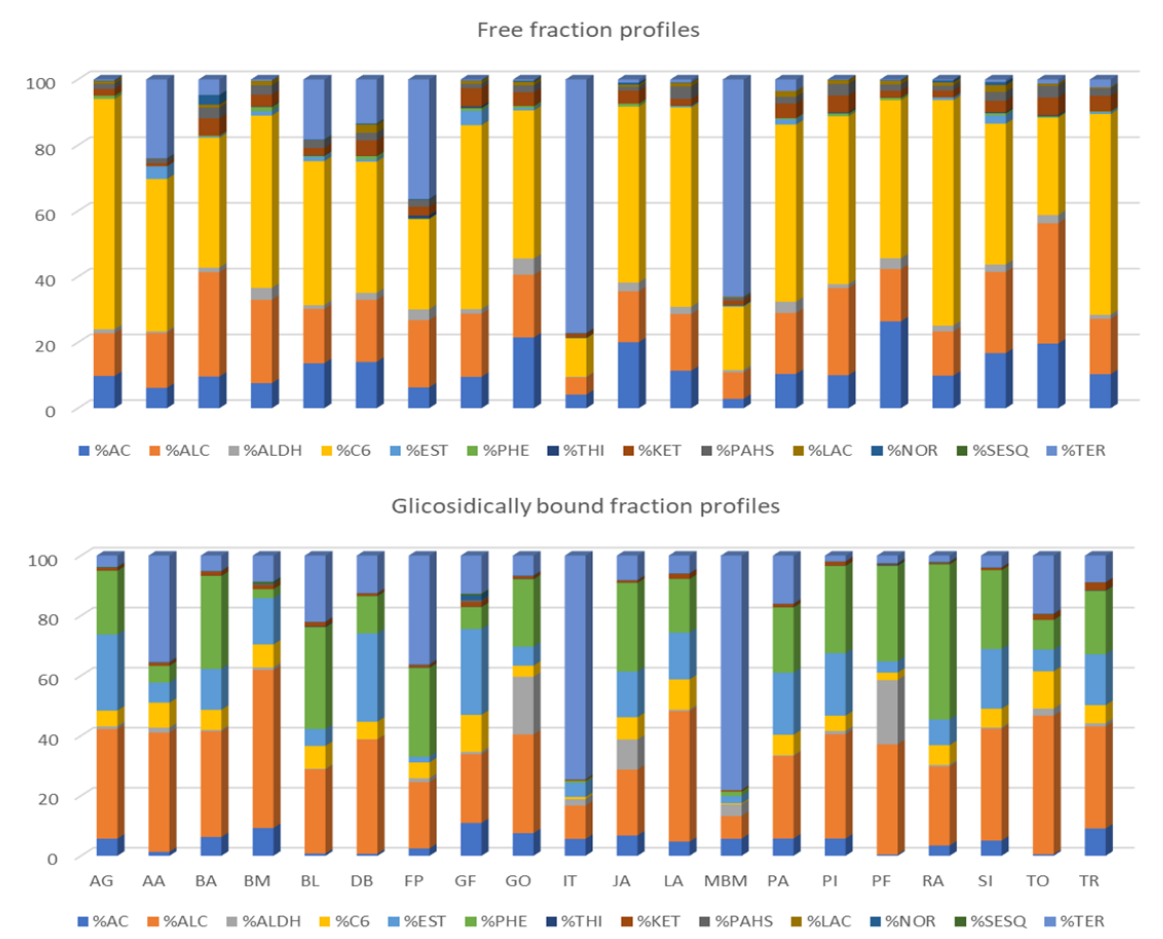
Figure 1. Aromatic family profile. % (AC: acids; ALC: alcohols; ALDH: aldehydes; EST: esters; PHE: